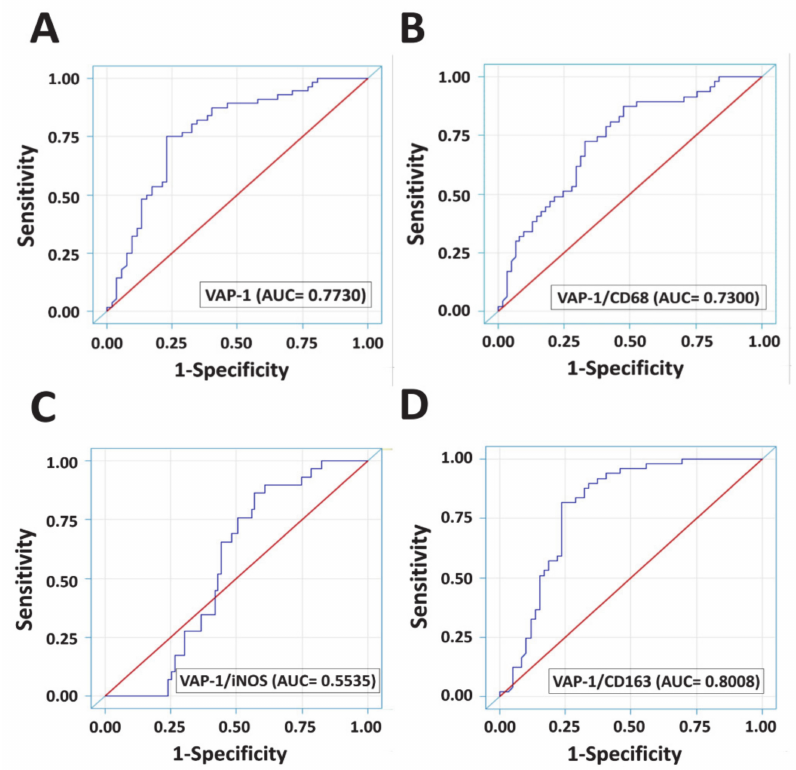
Figure 4. Analysis for the diagnostic accuracy of using VAP-1 expression and VAP-1 / TAM coexpression in gliomas by ROC curve. ROC analyses for the diagnostic accuracy of using VAP-1 expression alone ( A ) and in combination with TAM markers ( B , CD68; C , iNOS; D , CD163) were calculated. The AUC estimates evaluated by this approach are reported under the ROC association statistics section of data output. Abbreviations: AUC, area under the ROC curve. Abbreviations: ROC curves, receiver operating characteristic curves; AUC, the area under ROC